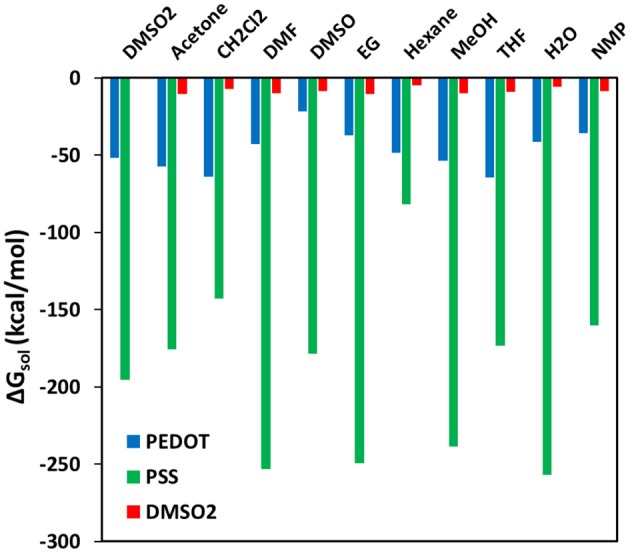
Free energy of solvation (ΔGsol) for SS18-3, EDOT9+3, DMSO2 in different solvents.